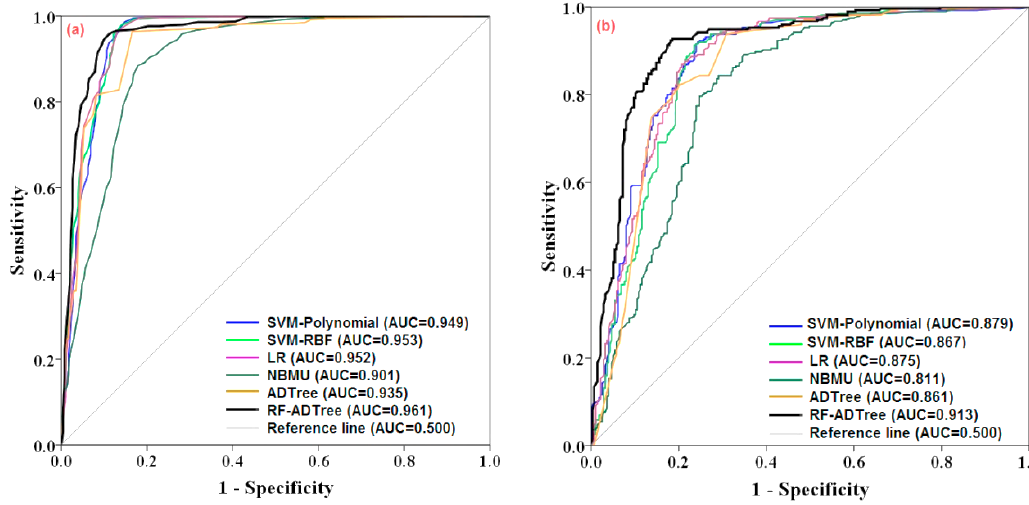
Figure 9. Model comparison using ROC ( a ) and AUC ( b ).